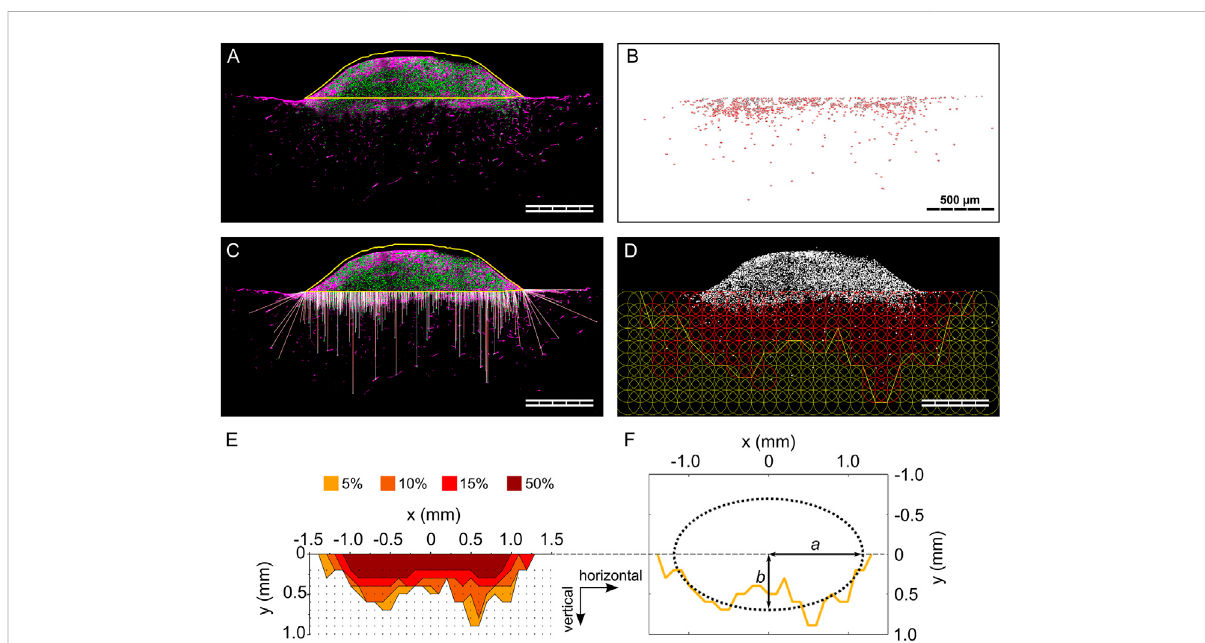
FIGURE 2 Individual steps of the analysis procedure for the 3D spheroid migration assay. (A) Outline of cell spheroid; (B) cell nuclei count within the biomaterial; (C) visualization of the calculated 3D migration distances ( d 3D ) for each cell; (D) visualization of the grid of ROIs and indication of the 5% isodensitypro fi le.Cellnucleiarevisualizedingray.ROIscontainingacelldensityequaltoorhigherthanthespeci fi edthresholdarecoloredinred; (E) overlay of 5%, 10%, 15%, and 50% isodensity pro fi les in the relative coordinate system. The black dots correspond to the points of the circular ROIs in the grid according to (D) ; (F) elliptic fi t exemplary shown for the 5% isodensity pro fi le. The semi-major and semi-minor axes ( a and b , respectively) are marked. All images refer to the same representative sample (MM) from one 3D spheroid migration experiment. Scale bars are 500 µm. (A and C) show cell nuclei in green and F-actin in